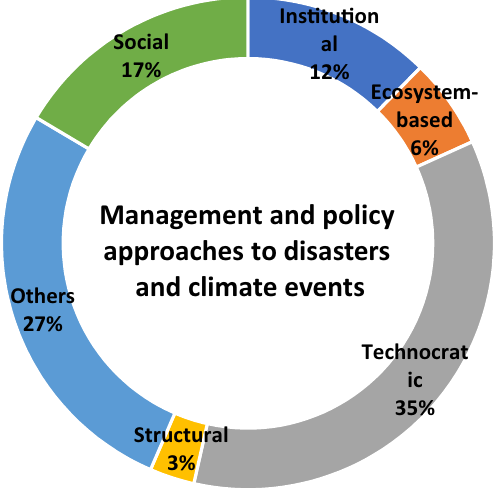
Fig. 6 Studies conceptualization of disasters and climate change Fig. 7 Studies recommendations of best practices for managing disasters and climate change